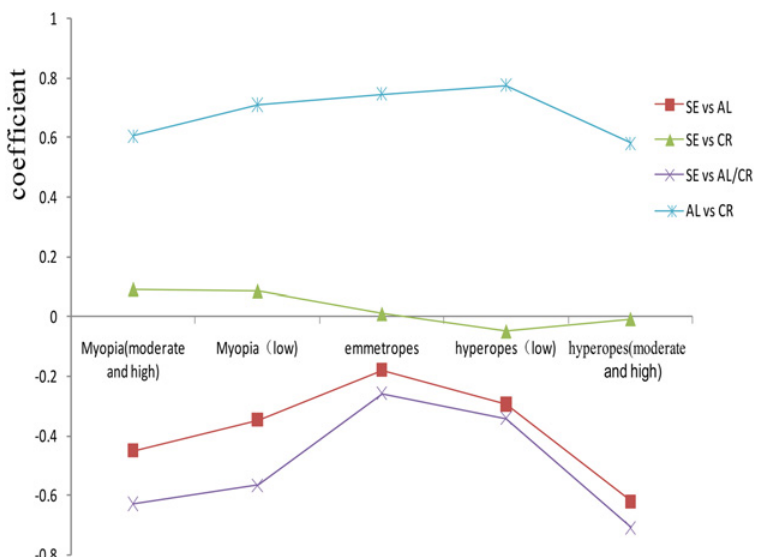
Fig 1. Correlation by refractive state. Myopia (moderate and high): SE (cid:1) -3.00D; Myopia (low): -3.00 D < SE (cid:1) -0.50 D; emmetropes: -0.50 D < SE < +0.50 D; hyperopes (low): +0.50 D (cid:1) SE < +2.00 D; hyperopes (moderate and high): SE (cid:3) +2.00 D.